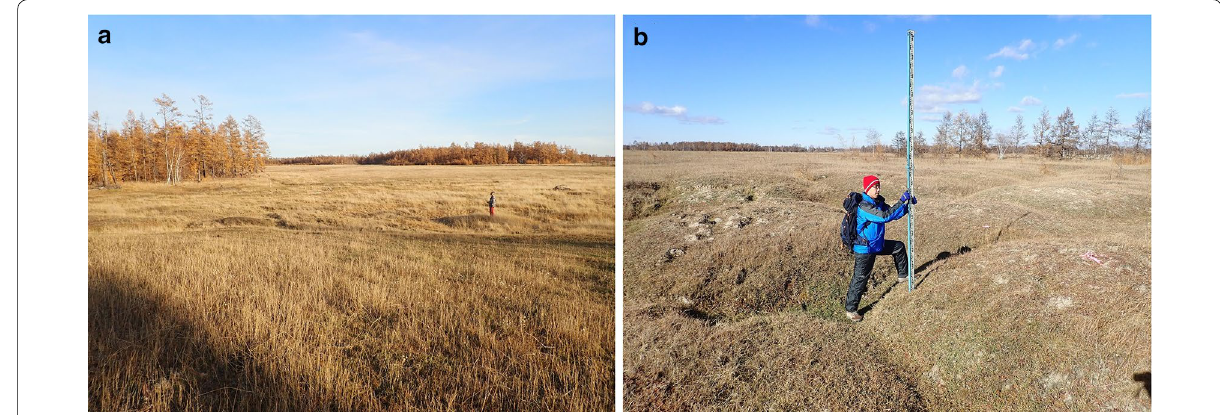
Fig. 6 Photographs at a the bottom area of the alas at A1 and, b Plot C in Fig. 2d. Polygonal texture is present at both the bottom area of the alas, and Plot